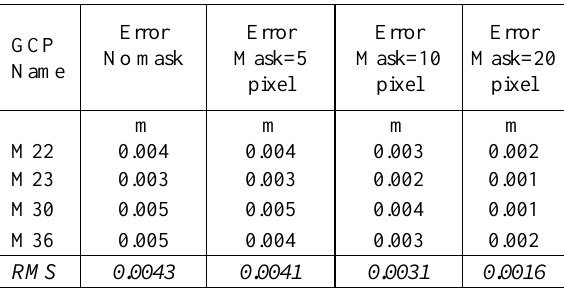
Table 6. Residuals of the markers obtained with action camera